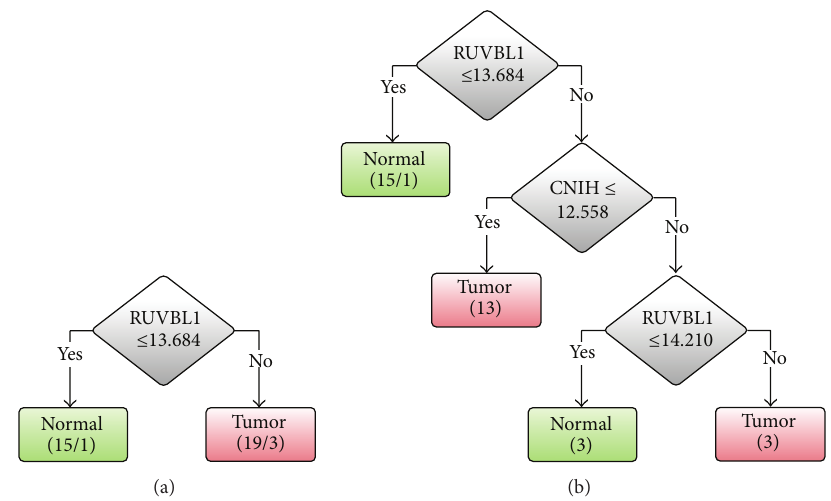
Figure 4: Decision tree classifiers based on our dataset using (a) RUVBL1 and (b) both RUVBL1 and CNIH.